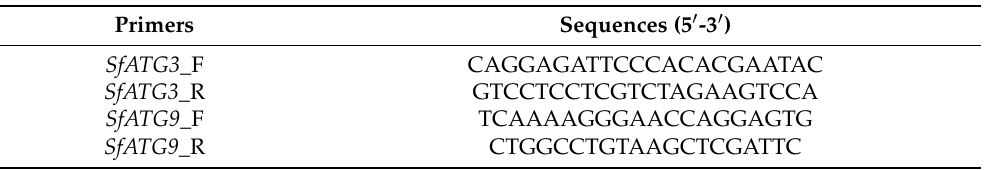
Table 1. Sequences of primers used for qPCR of autophagy-related genes and SRBSDV genes S9-1 and S10 and synthesis of ds GFP , ds ATG3, and ds ATG9